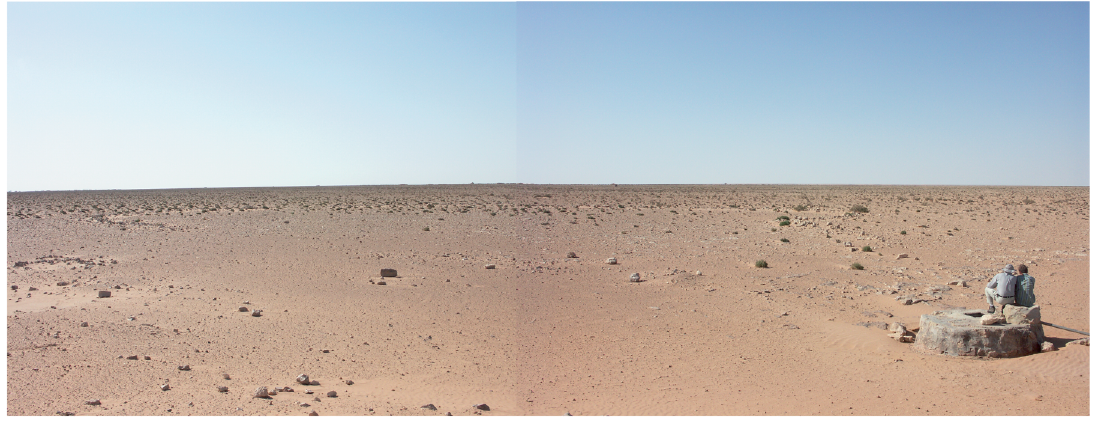
Fig. 5. Surrounding landscape at the cistern of Abar Abu Imama on the Northern Marmarica-Plateau (cf. fig. 4). (Anna-Katha- rina